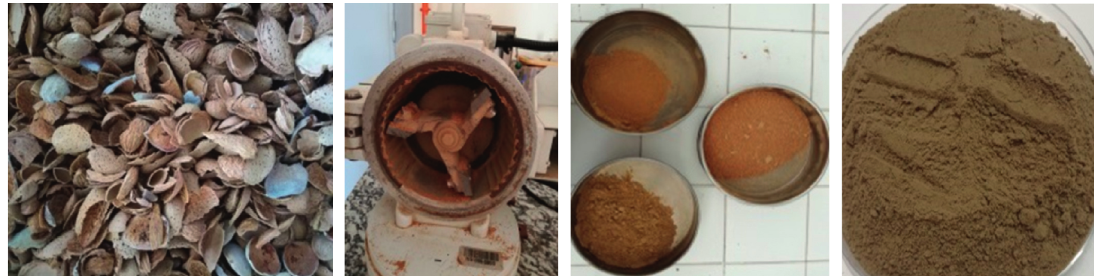
Figure 1: The followed steps in the preparation of adsorbent powder from almond shells: almond shells’ grinding, sieving, and size grading. Almond shell powder (ASP) for adsorption